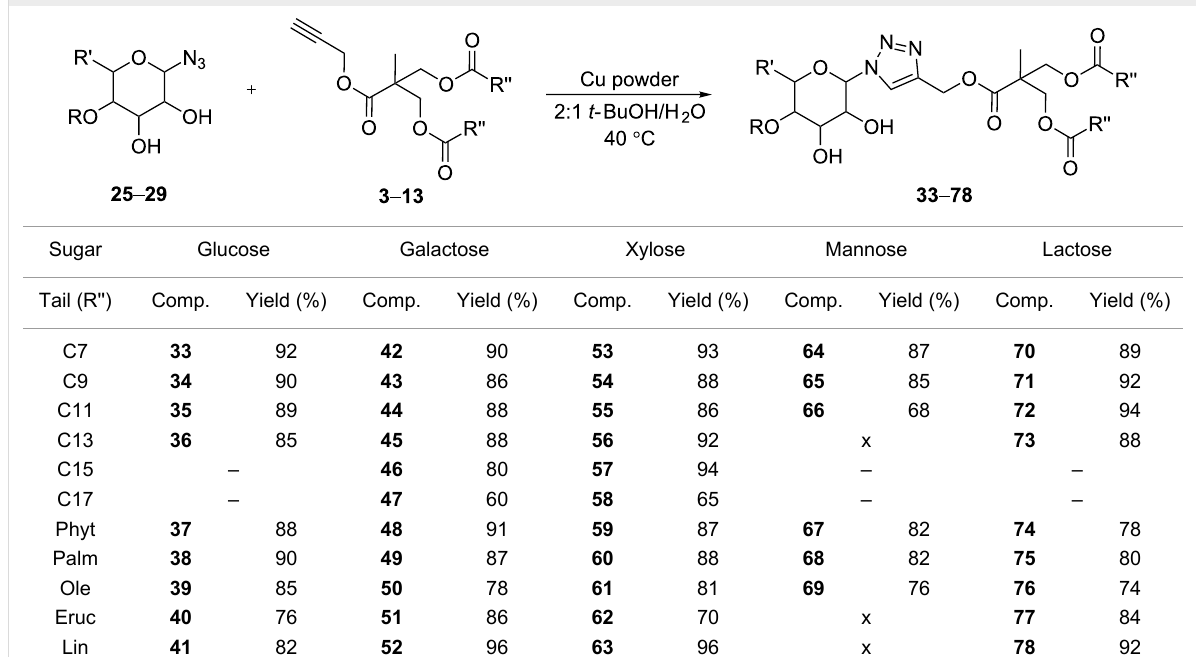
Table 2: Synthesis of double-chained amphiphiles. a